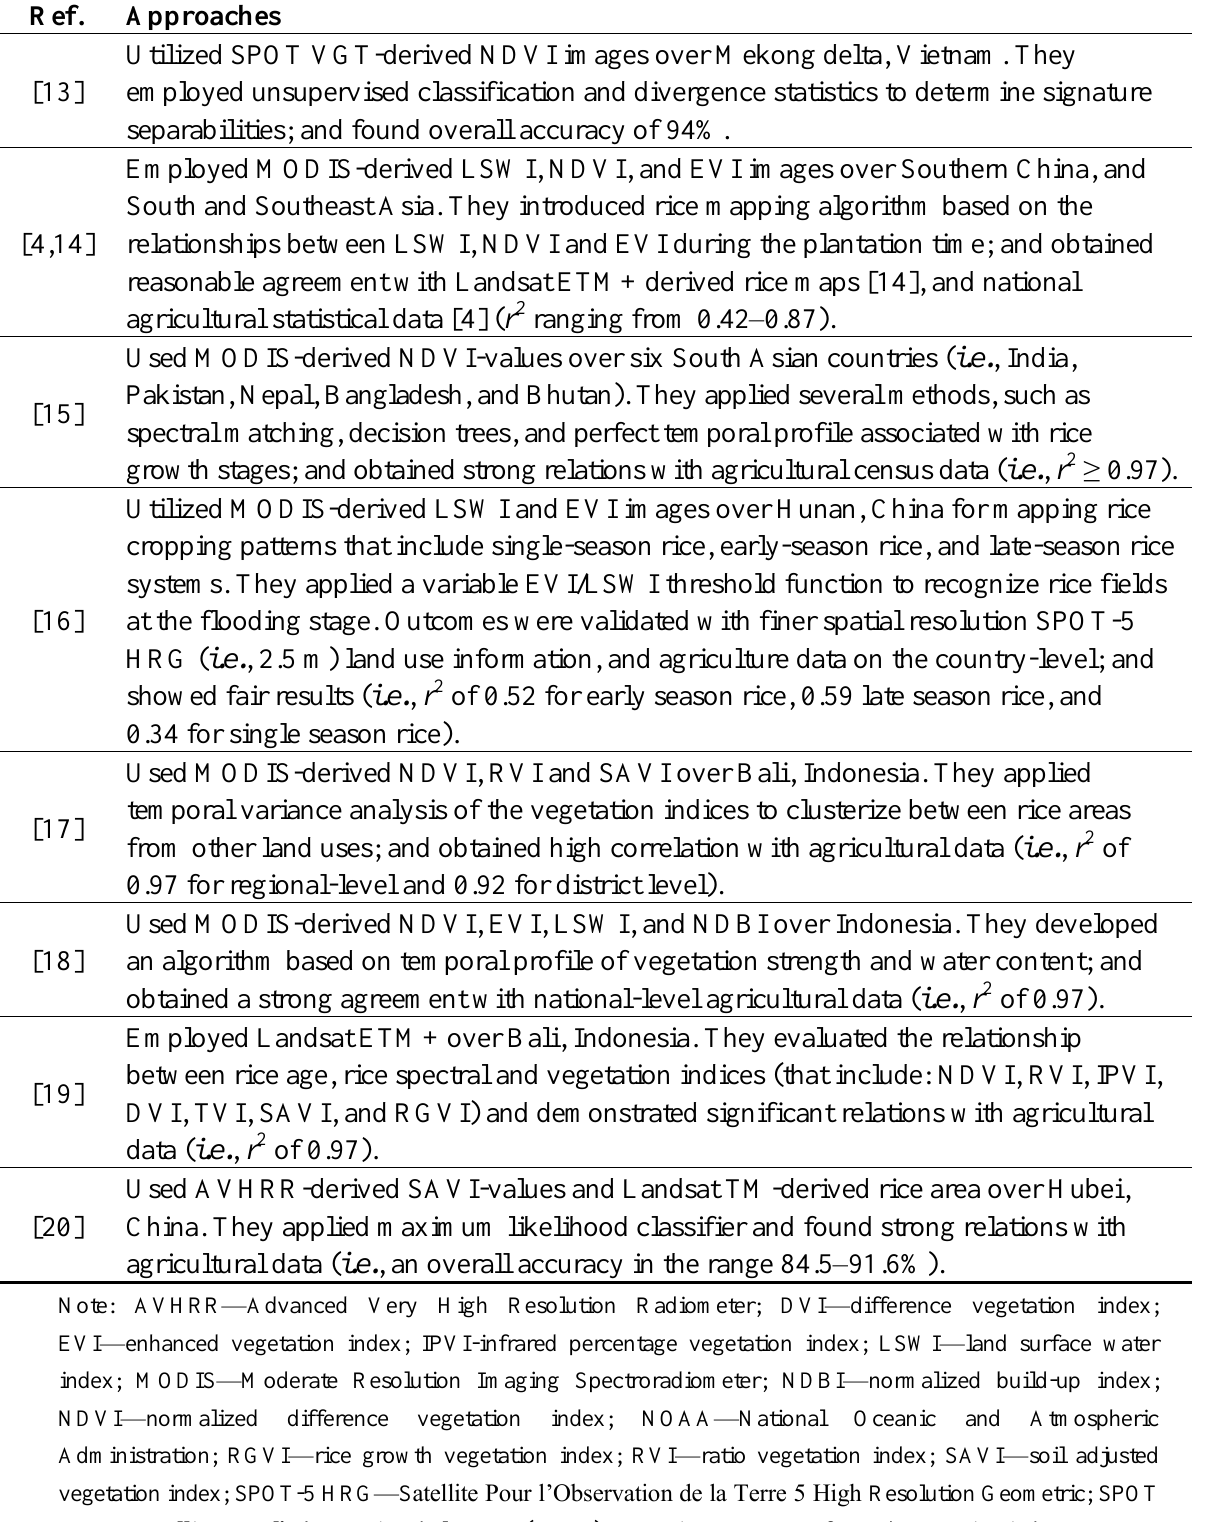
Table 1. Examples of vegetation indices appearing in the literature used for mapping rice